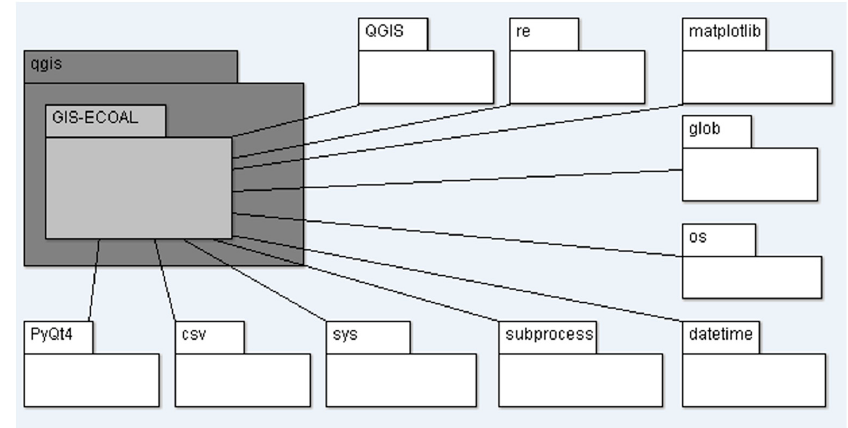
Figure 6. GIS-ECOAL application package diagram.